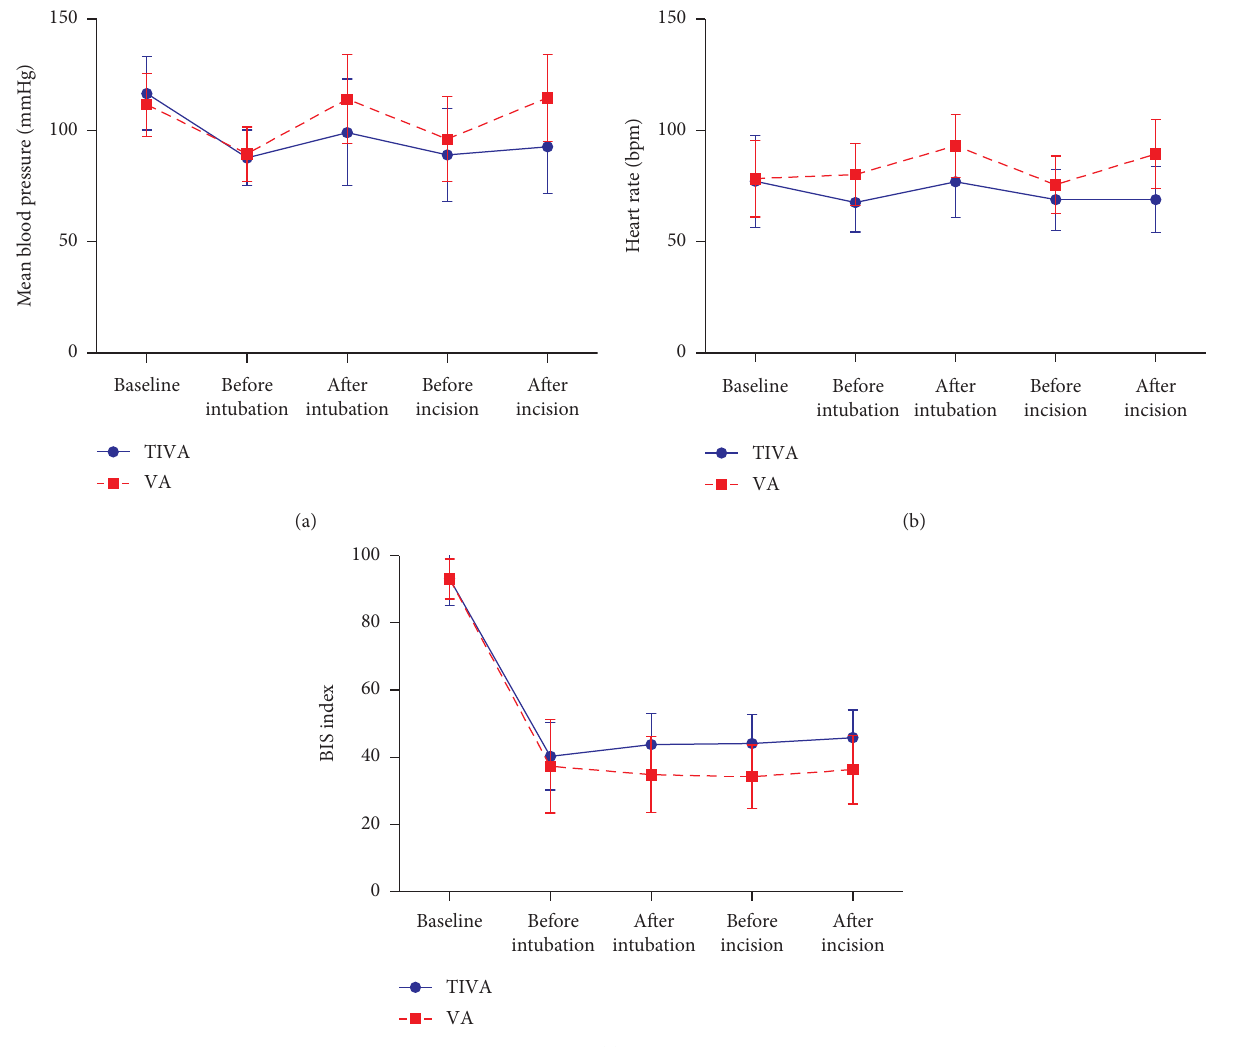
Figure 3: The changes in mean blood pressure, heart rate, and bispectral (BIS) index during surgery. TIVA � total intravenous anesthesia; VA � volatile